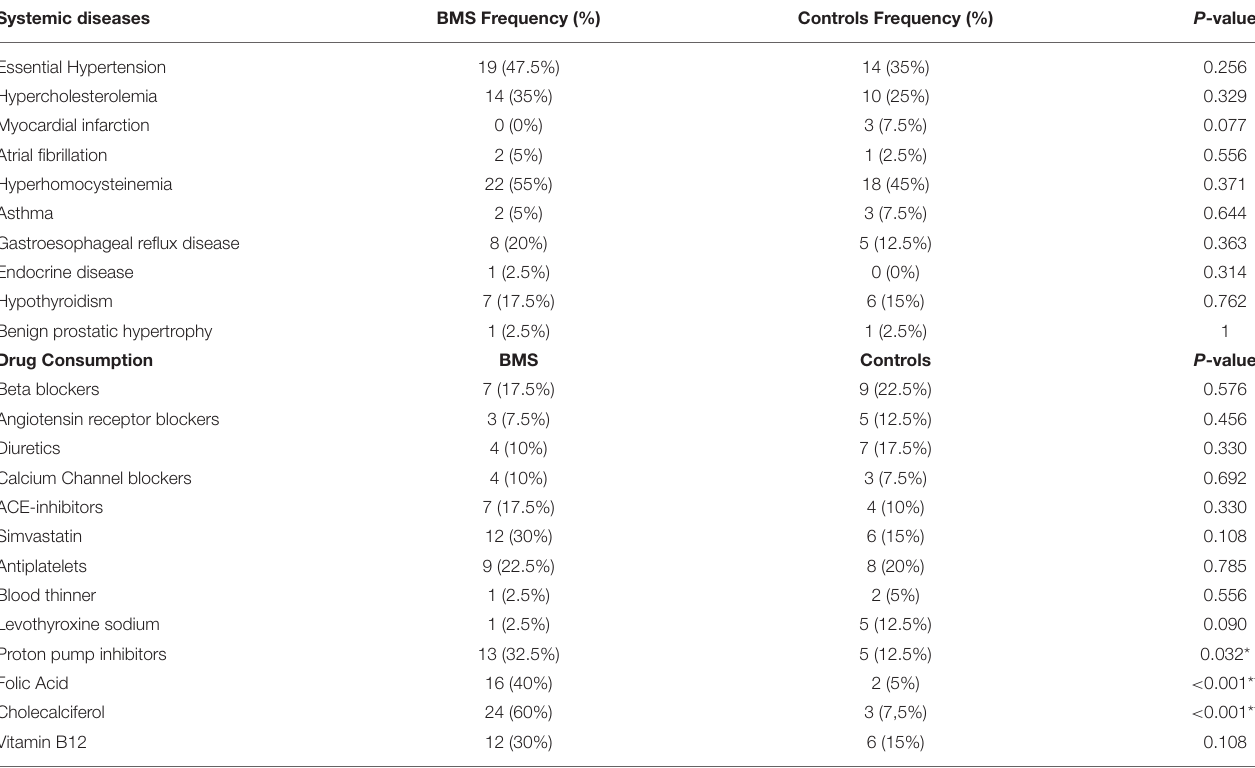
TABLE 2 | The prevalence of systemic diseases and the drug consumption of patients with BMS and control subjects. Systemic